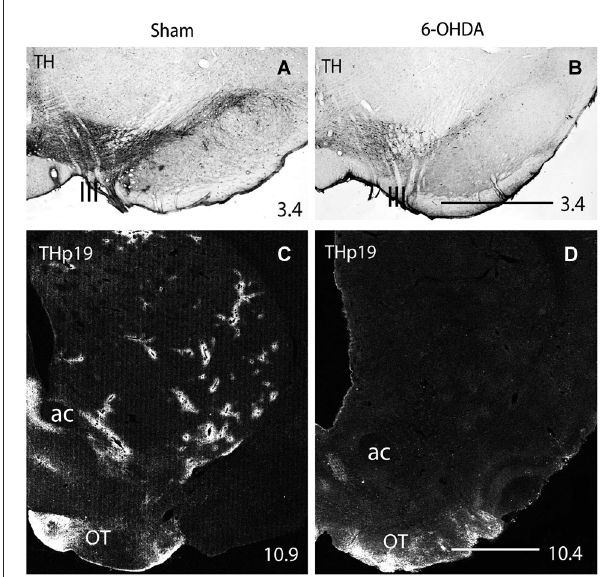
FIGURE 4 | (A,B) Immunohistochemistry for TH in the rat midbrain after sham (A) and 400 µ g 6-OHDA (B) intracerebroventricular injection. (C,D) Immunofluorescence for THp19 in the striatum of sham (C) and 400 µ g 6-OHDA (D) injected rats. One can see the decrease in the number of TH-positive midbrain cells after 6-OHDA injection (compare A and B ), and that THp-19 striatal perivascular plexuses disappear after midbrain DA-cell degeneration (compare C and D ). ac, anterior commissure; OT, olfactory tubercle; III, fibers of the third cranial nerve emerging in the surface of the ventral midbrain. Numbers at the bottom right indicate the distance from the interaural axis in millimeters. Bar in (B) (for A and B ), 1 mm; in (D) (for C and D ), 1 mm.